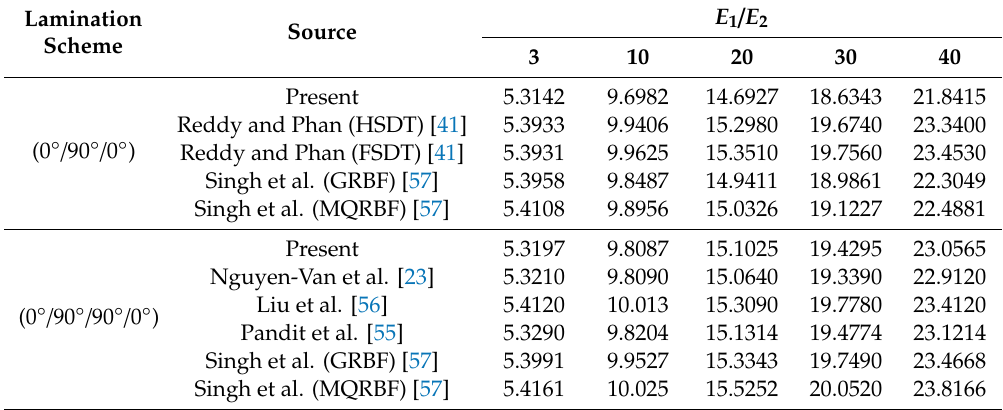
Table 2. Validation of nondimensional buckling load λ = ( λ b 2 /E 2 h 3 ) for a uni-axial buckling of simply